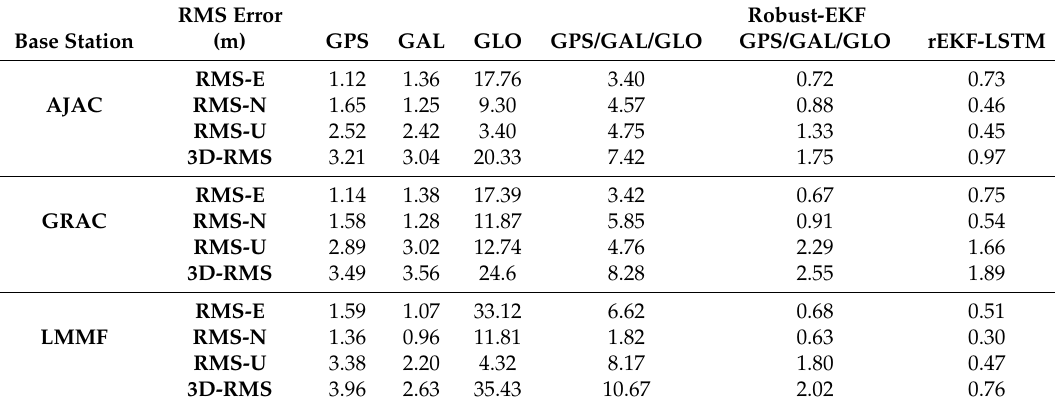
Table 5. RMS Errors in Position at the three AJAC, GRAC LMMF stations in late 12